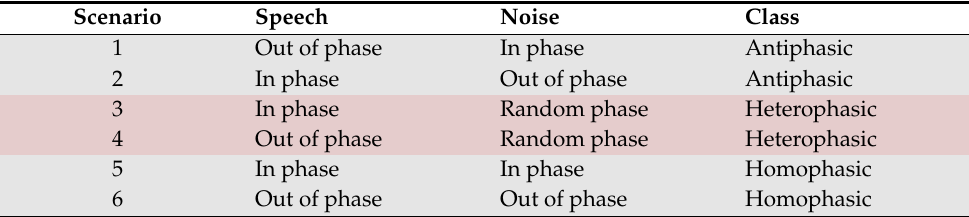
Figure 1. Illustration of different phase scenarios and the influence of the interaural phase relations on the localization of speech and white noise in space. The circle shape means that the signal is concentrated in a limited area, in front of the head for the case of in phase or on either side of the ears for the case of random phase. The rectangle shape indicates that the signal spreads in the area behind the ears, which is related to the case of out of phase. The red dotted circle indicates that the speech signal and the white noise are both in phase, which is related to the monaural superdirective beamformer. The blue circle indicates that the speech signal is in phase while the white noise is in random phase, which is related to the binaural superdirective beamformer developed in this work. This figure is a modified version of the results in [49]. Table 1. Different scenarios for intelligibility study based on phase relationship between speech and noise